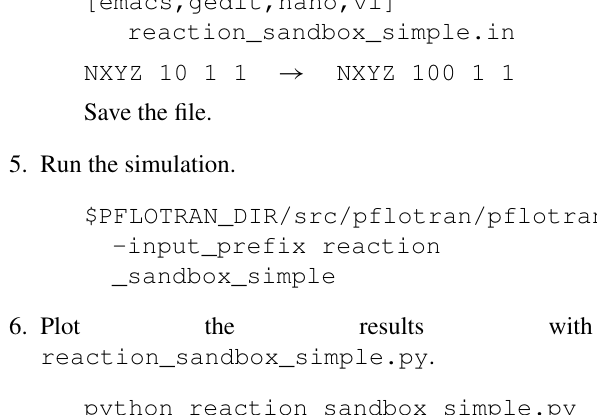
Table 4. Reaction Sandbox Simple conceptual